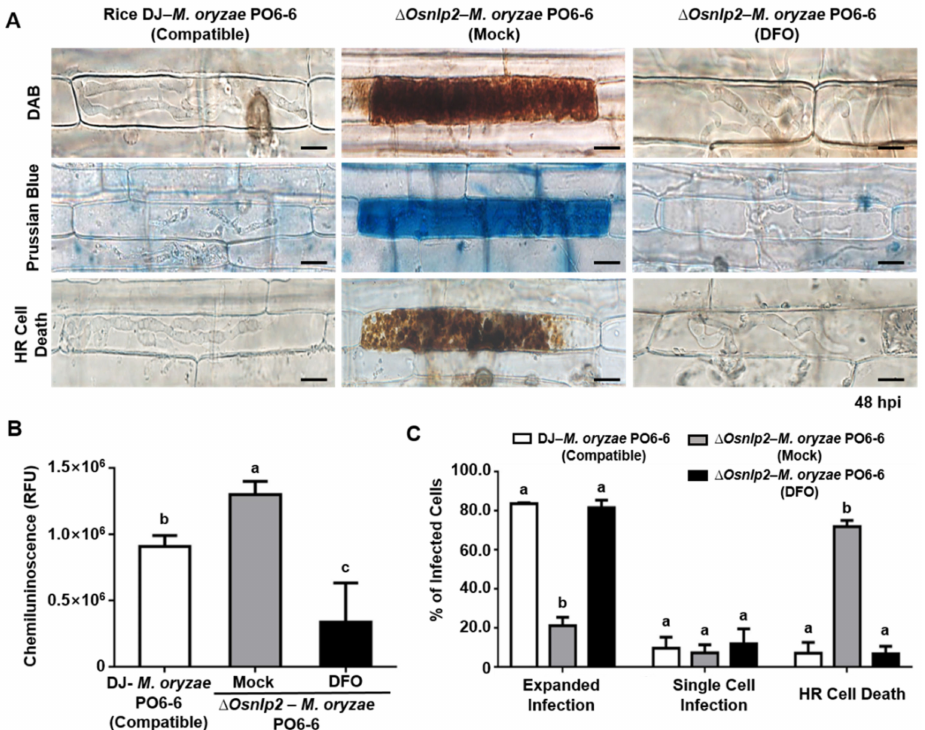
Figure 4. The iron chelator deferoxamine (DFO) suppresses the accumulation of ROS and ferric ions and HR cell death in ∆ Osnlp2 leaf sheaths infected with virulent Magnaporthe oryzae PO6-6. ( A ) Inhibition of ROS and ferric ion accumulation and HR cell death in infected rice cells treated with 3 mM DFO. Leaf sheaths of rice DJ and ∆ Osnlp2 mutant line #4-2 were inoculated with M. oryzae PO6-6. ROS accumulation was detected by DAB staining, and ferric ion (Fe 3+ ) accumulation was visualized by Prussian blue staining. The images shown were taken using a fluorescence microscope (Zeiss equipped with Axioplan 2). hpi, hours post inoculation. Scale bars = 10 µ m. ( B ) ROS quantification in infected rice leaf sheaths treated with 3 mM DFO. ROS quantities in rice cells were determined by a chemiluminescence assay. Values are means ± SD of relative luminescence units (RLU) ( n = 10) from different rice sheath discs. ( C ) Quantification of infection types in rice sheaths treated with 3 mM DFO. The cell numbers of different infection types were counted at 48 hpi using a microscope. The percentages of infected cells are presented as means ± SD from the cell numbers of infection types in rice sheaths of different plants ( n = 4). Different letters above the bars indicate significantly different means as determined by the least significant difference (LSD) test ( p <